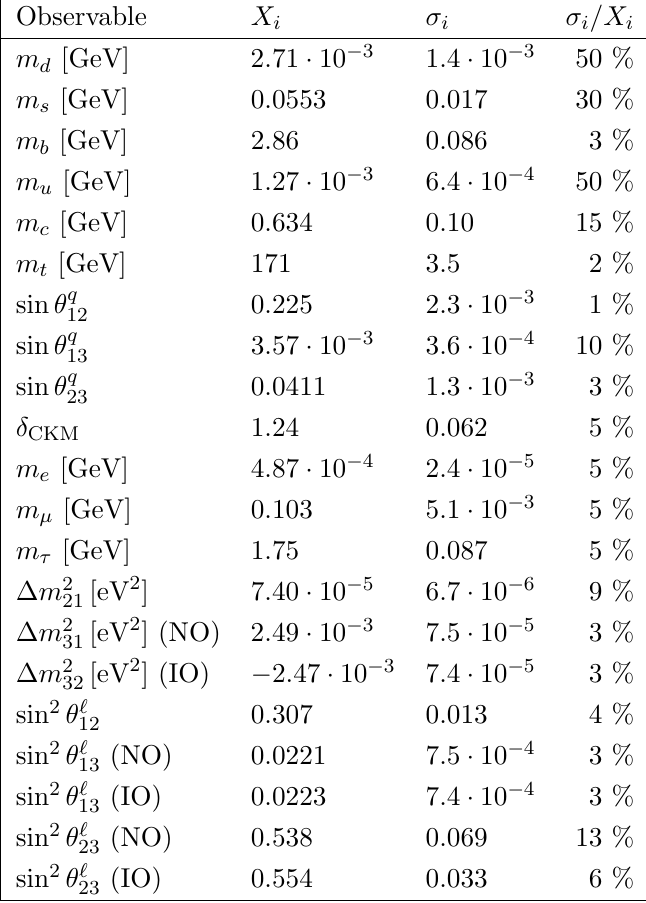
the vevs are sampled from uniform priors between (cid:0) 550 GeV and 550 GeV, except for v